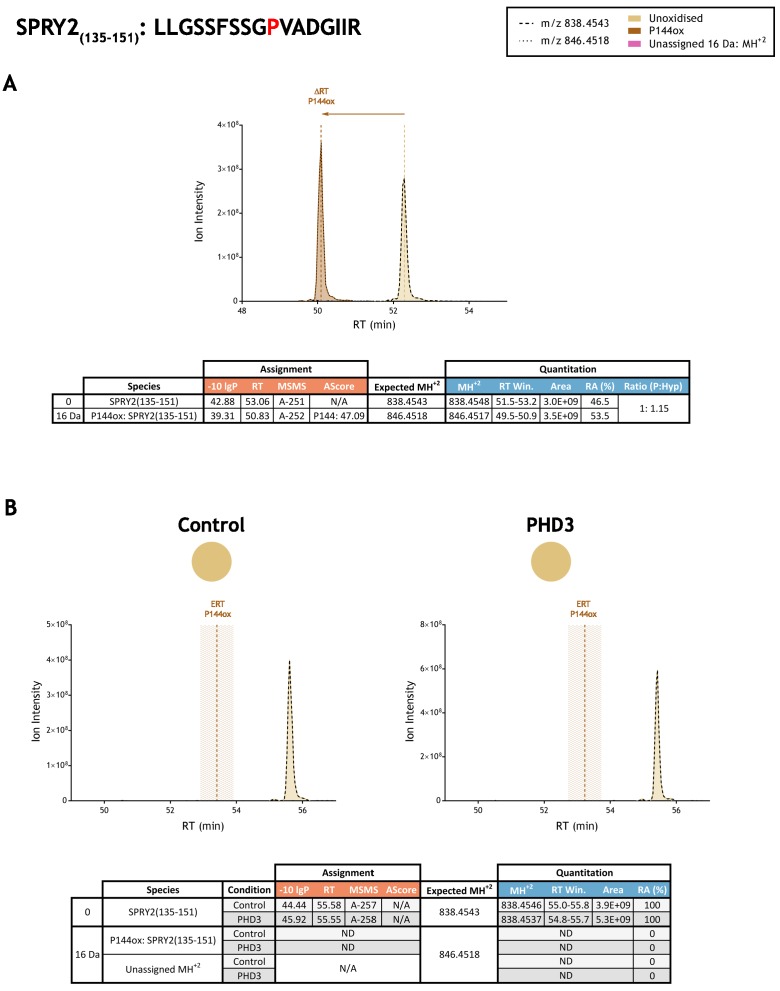
Quantitation of peptide oxidation on SPRY2(135–151) following reaction of full-length sprouty homolog 2 with recombinant PHD3.XIC data presented in (A) shows ion intensity and retention time (RT) characteristics of equimolar synthetic peptide standards for unoxidised and P144ox forms of the SPRY2(135–151) peptide. MSMS assigned species are coloured (see inset); vertical dashed lines define peak maxima used to derive ΔRT values for P144ox. Panel (B) shows comparable XIC data for protease-digested IVTT substrate under control (left) or PHD3-reacted (right) conditions. Peaks corresponding to unoxidised SPRY2(135–151) were assigned by MSMS (see inset for colour code); P144ox was not detected. The estimated RT (ERT) for P144ox, derived from (A), is indicated by dashed vertical line, shading corresponds to a 1 min RT window. Unassigned ions of compatible mass over charge for hydroxylation were not observed across the elution window. Quantitative data for observed species are presented as pie charts with XIC data. Assignment and quantitation data are tabulated below each panel, table headers are as follows: (−10lgP) significance score of leading assignment at given (RT) with ambiguity score (AScore) for PTM localisation and reference to primary MSMS data in Supplementary file 1. Quantitative data reports ion counts (Area) of observed masses (MH+2) integrated over time (RT Win.), expressed as relative abundance (RA). Data on detection efficiency for synthetic peptides (Panel A, P: Hyp) is an aggregated ratio of prolyl (P) to hydroxyprolyl (Hyp) containing species.